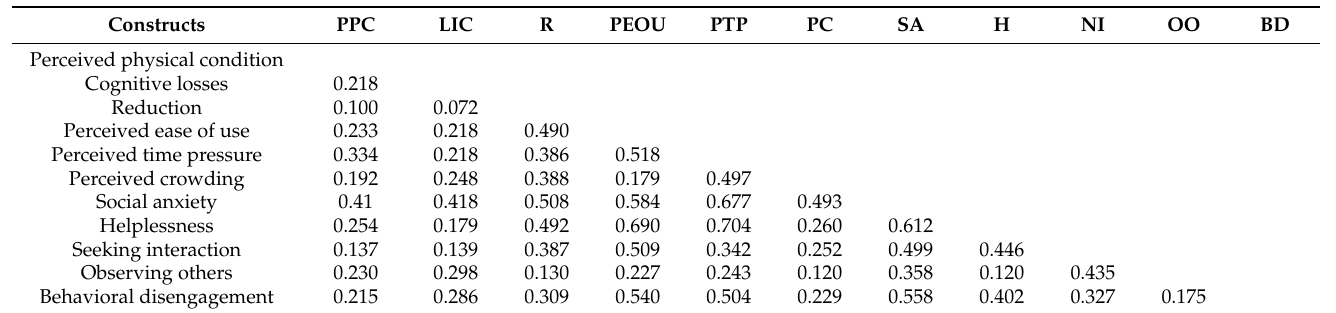
Table 4. Discriminant validity (Heterotrait-Monotrait